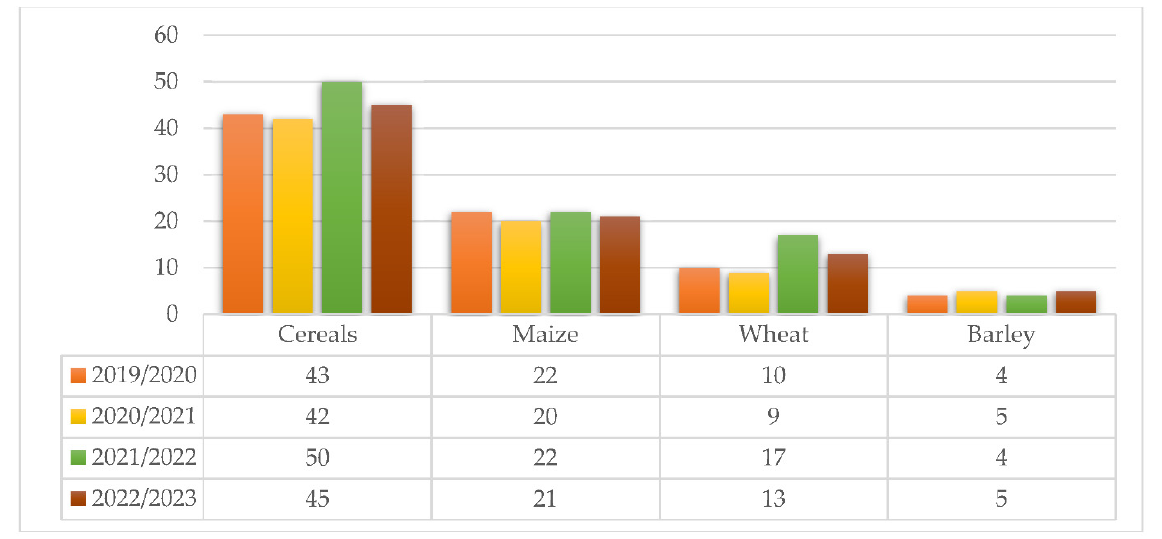
Figure 2. Evolution of agricultural stocks at EU level (million tonnes) Source: realised by authors after [3].